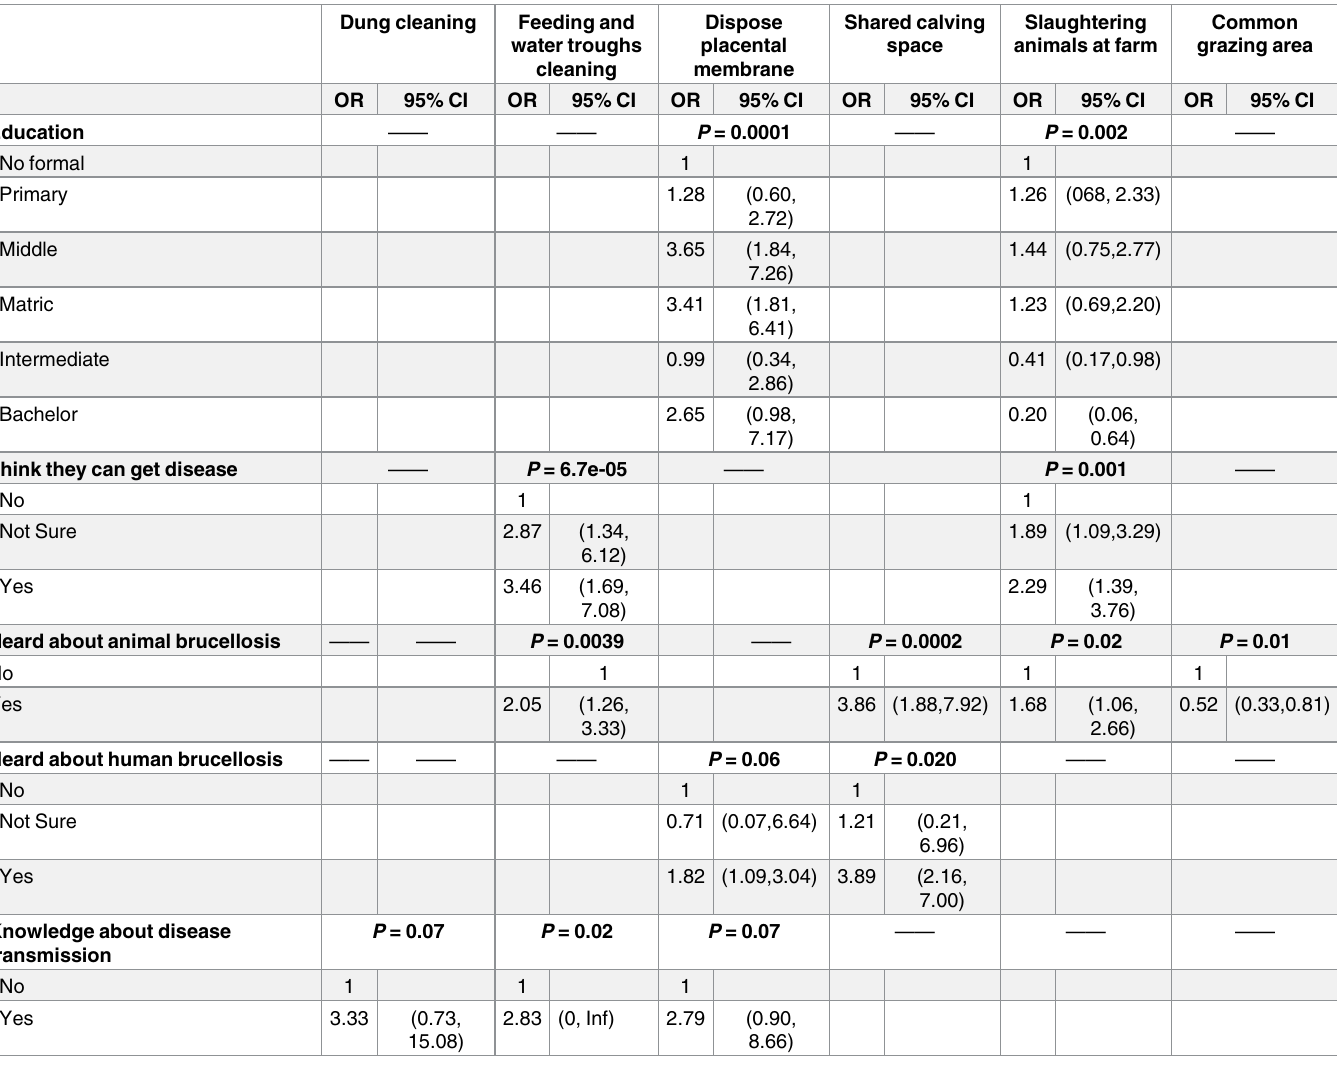
Table 7. Summary of the final multivariable models for herd management risky practices. Columnsof the table refer to specific practices(outcomevar- iables) and rows refer to predictor variablesafter the backward elimination process. P -valuesare shown for each predictor variable,followedby the odds ratio (OR) and95% confidenceinterval(95%CI) for the OR, relativeto the referencegroup(OR = 1). No entries(——) indicatewherethere was no significantasso- ciation in the final multivariablemodel. Dung cleaning Feeding and Dispose Shared calving Slaughtering Common water troughs placental space animals at farm grazing cleaning membrane